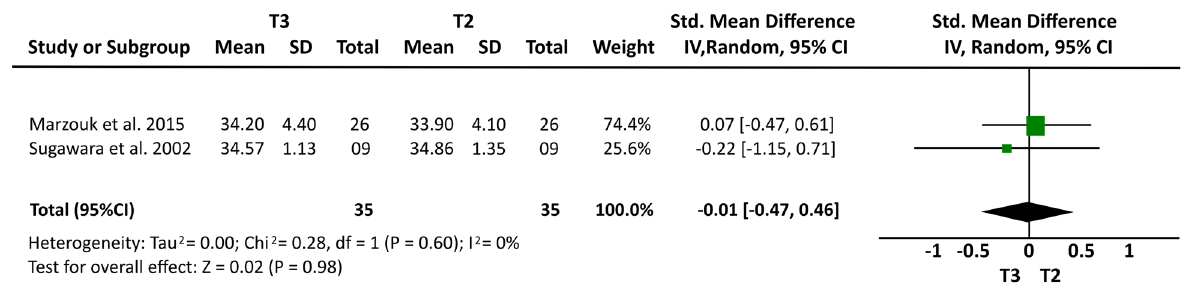
Fig. 4 Forest plot of L6-MP difference between T2 and T3 in patients who used TADs for molar intrusion after 1-year follow-up. 95% confidence interval and 95% prediction